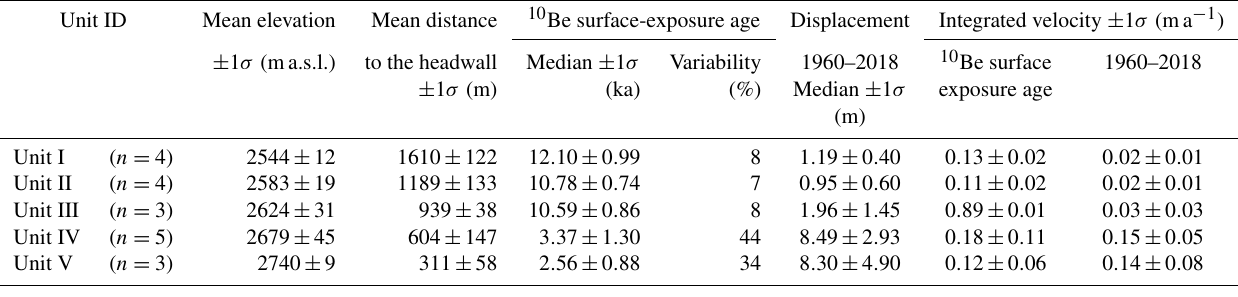
Table 4. Median value of the 10 Be surface-exposure ages for each unit of the rock glacier system of the Vallon de la Route (Combeynot Massif, France), where n represents the number of samples per unit. Surface velocity calculated from 10 Be surface-exposure dating (distance from the headwall divided by 10 Be surface-exposure age) and from image correlation (IMCORR, SAGA package on QGIS) of orthoimages (1960–2018 interval).